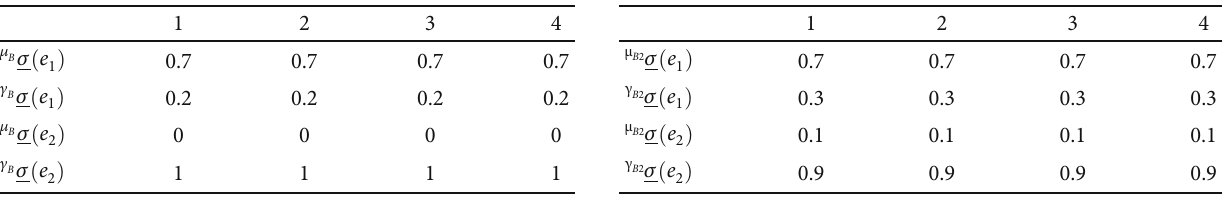
Table 39: Lower approximation of B